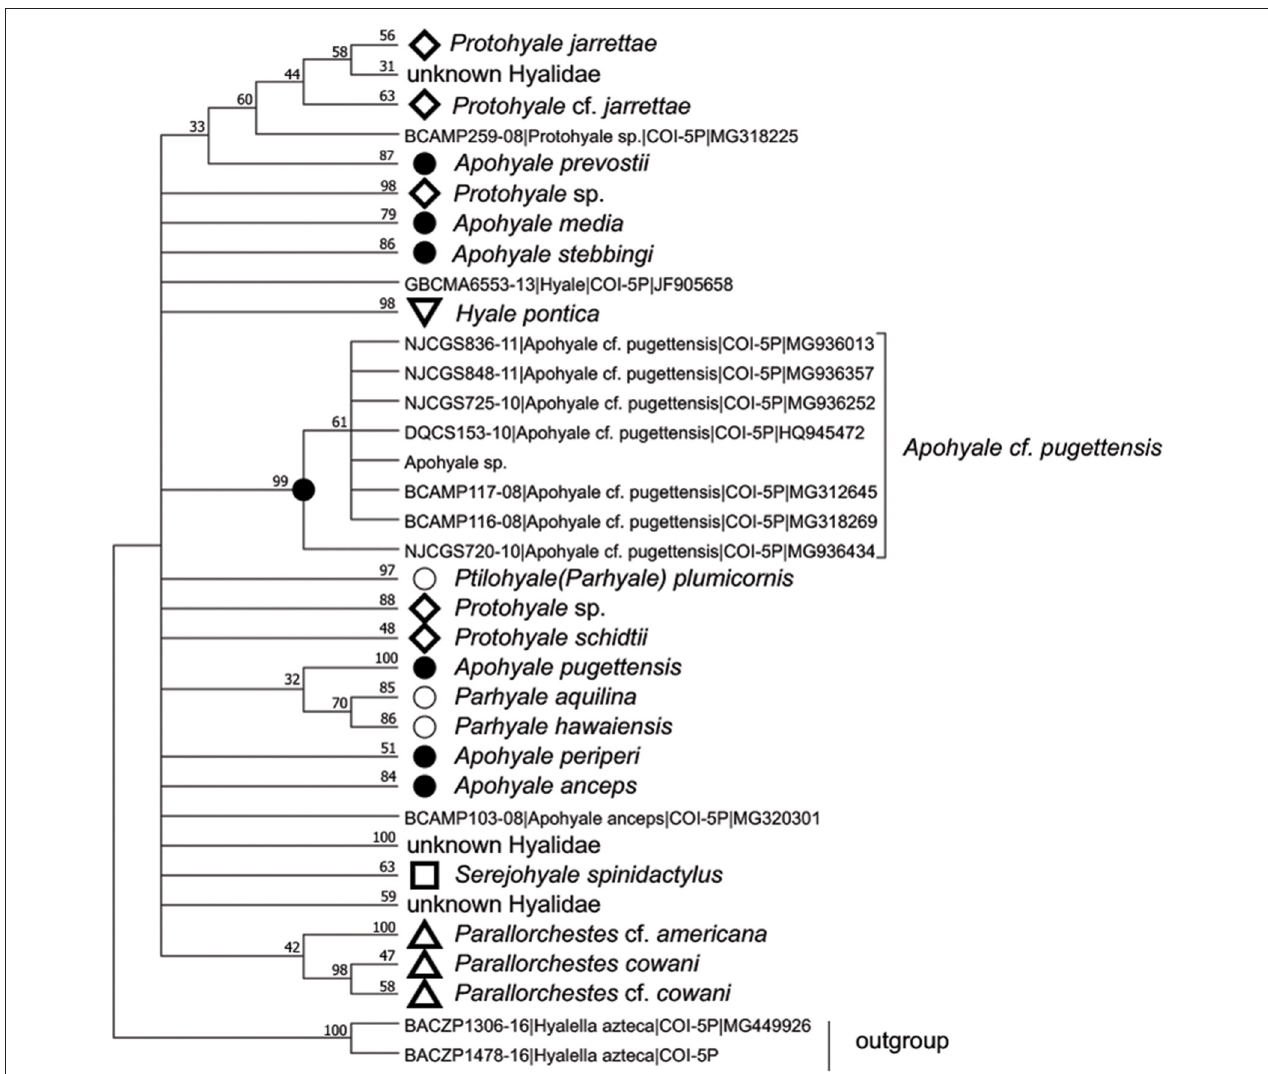
FIGURE 3 | The condensed ML phylogenetic tree based on the amino acid sequences of COI in Hyalidae with cut-off value > 30%. The monophyletic clade of each species was compressed and labeled with the specific markers and species names. Numbers above lines are bootstrapping support value (%) after 1,000 permutations. Apohyale sp. represents the sequence from this research. ML, Maximum-likelihood; COI, cytochrome oxidase